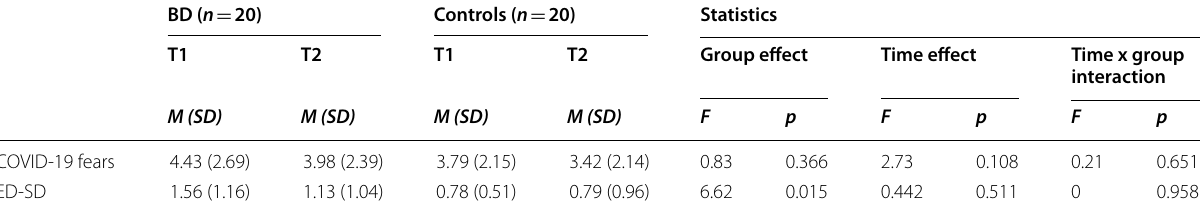
Results from repeated measures ANCOVAs controlling for age, sex, education, and employment BD bipolar disorder, ED-SD emotional distress due to social distancing, M mean, SD standard deviation